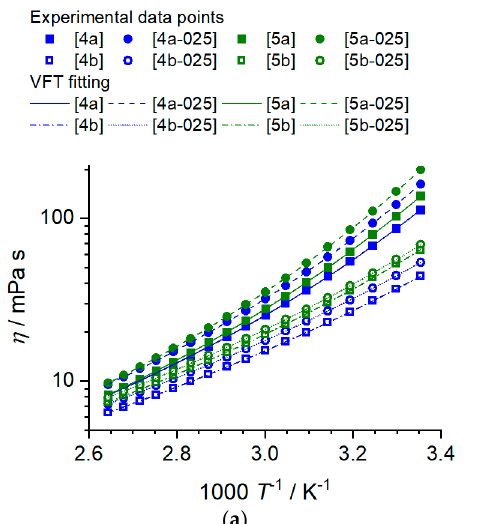
Figure 5. Dynamic viscosity in dependence of temperature for the bulk ILs and the IL–salt mixtures. ( a ) shows the n -alkyl phosphonium ionic liquids and salt mixtures and ( b ) the ether-containing phosphonium ionic liquids and IL salt mixtures. Table 5. Specific conductivity κ at 25 ◦ C, VFT fitting parameters ( κ 0 , B κ , T 0, κ ) Angell strength parameter δ κ and activation energy E a, κ (in the range of 25 to 60 ◦ C) for the T -dependent conductivity data.